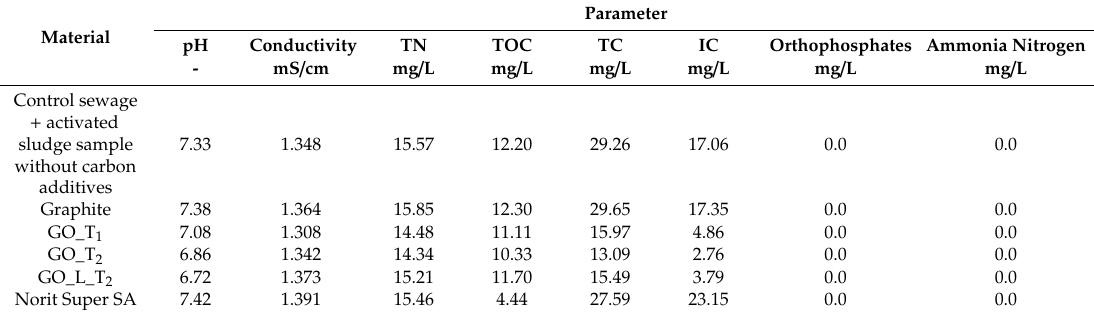
Table 5. Results of wastewater physicochemical analysis after 24 h reaction with activated sludge and selected carbon materials (dose 0.5 g /